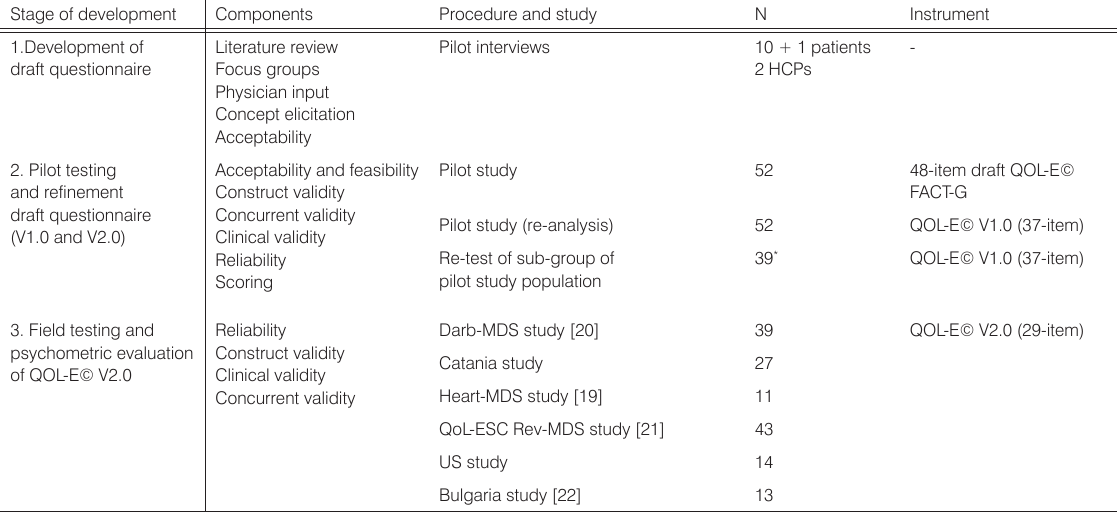
Table 1. Development of the QOL-E© instrument and study descriptions Stage of